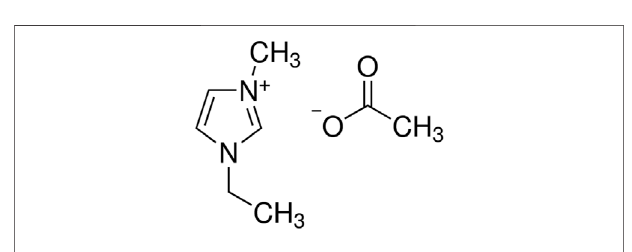
FIGURE 2 | Structural formula of hydrogenous 1-ethyl-3- methylimidazolium acetate (EmimAc).